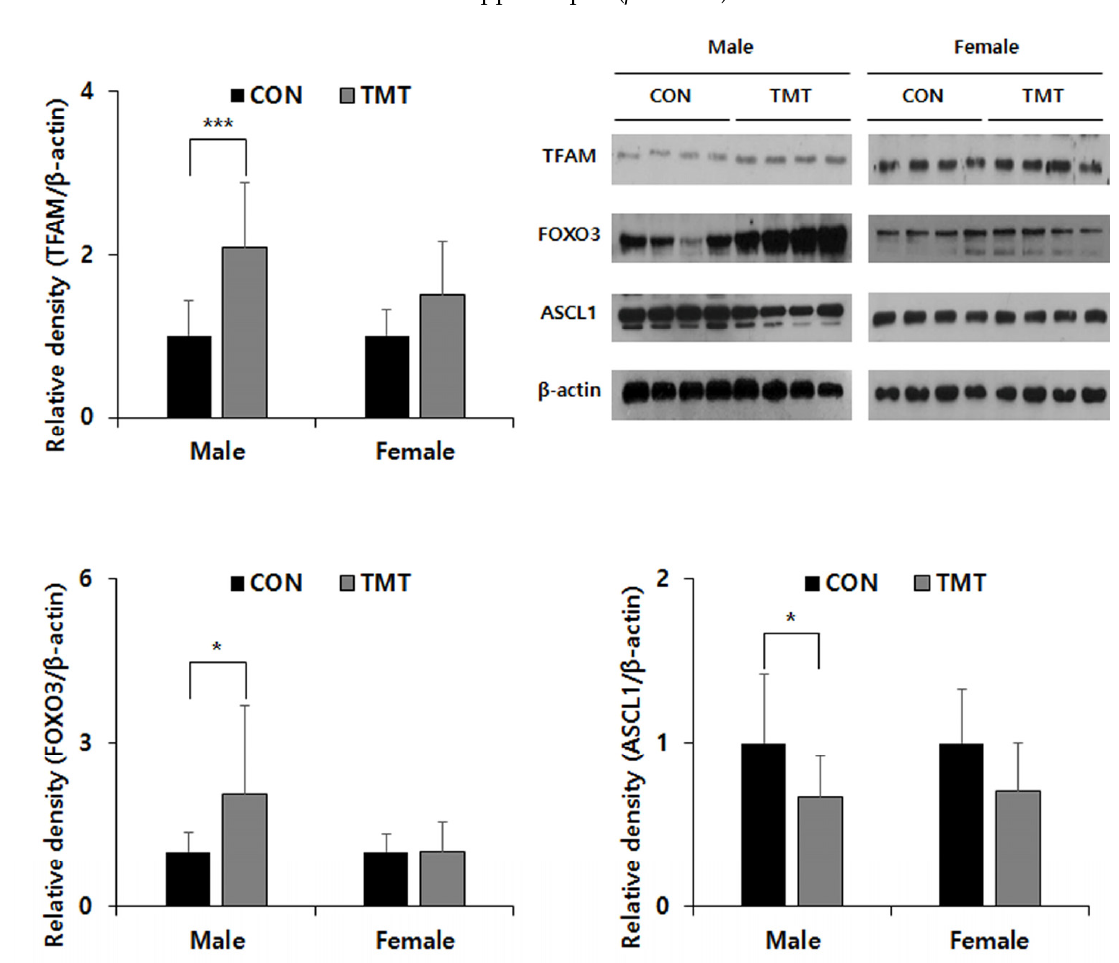
Figure 3. Protein expression of TFAM, FOXO3 and ASCL1 in the VPA exposed hippocampus. FOXO3, Forkhead box O3a; TFAM, Transcription Factor A, Mitochondrial; ASCL1, Achaete-Scute Family BHLH Transcription Factor 1. * p < 0.05, *** p < 0.001 compared to control (CON). Data are shown as means ± standard deviations (SD).